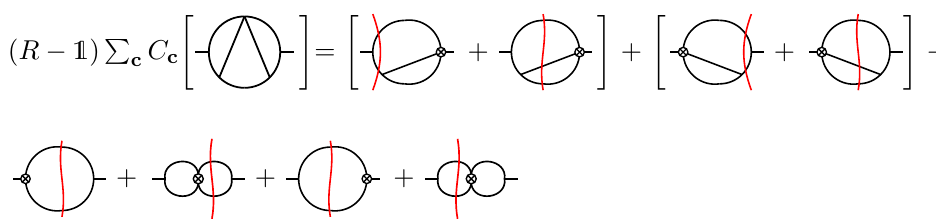
Figure 5. Applying the R -operation on the sum of all the interference diagrams arising from a given forward-scattering diagram yields IR-finite contributions. In particular, each expression in square brackets of the first line is separately IR finite, and each diagram on the second line is also IR finite, provided that q 2 > 0